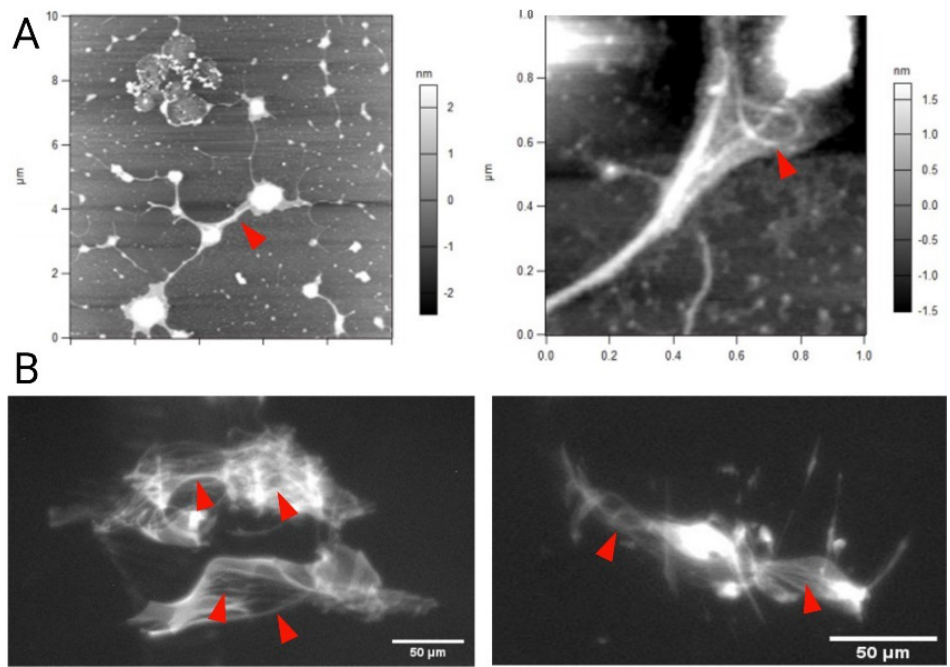
Figure 10. ( A ) The AFM study with height trace of mucin fibers deposited on a mica surface showing the mucin fibers (marked with red arrowhead), individually and in agglomeration with others, thus forming bundles, viewed on a larger field ( left panel) and a closer zoomed-in view ( right panel). The scale bar is provided at the sides of the images. ( B ) The epifluorescence images of (both left and right panels) mucin fibers bound to C6@CNCs. The red arrowheads mark the mucin fibers. No such binding was observed for the C6@M-CNCs. Scale bars (50 µm) are embedded within the images. The reference AFM data helped to exclude any agglomeration of C6@CNCs providing noise.